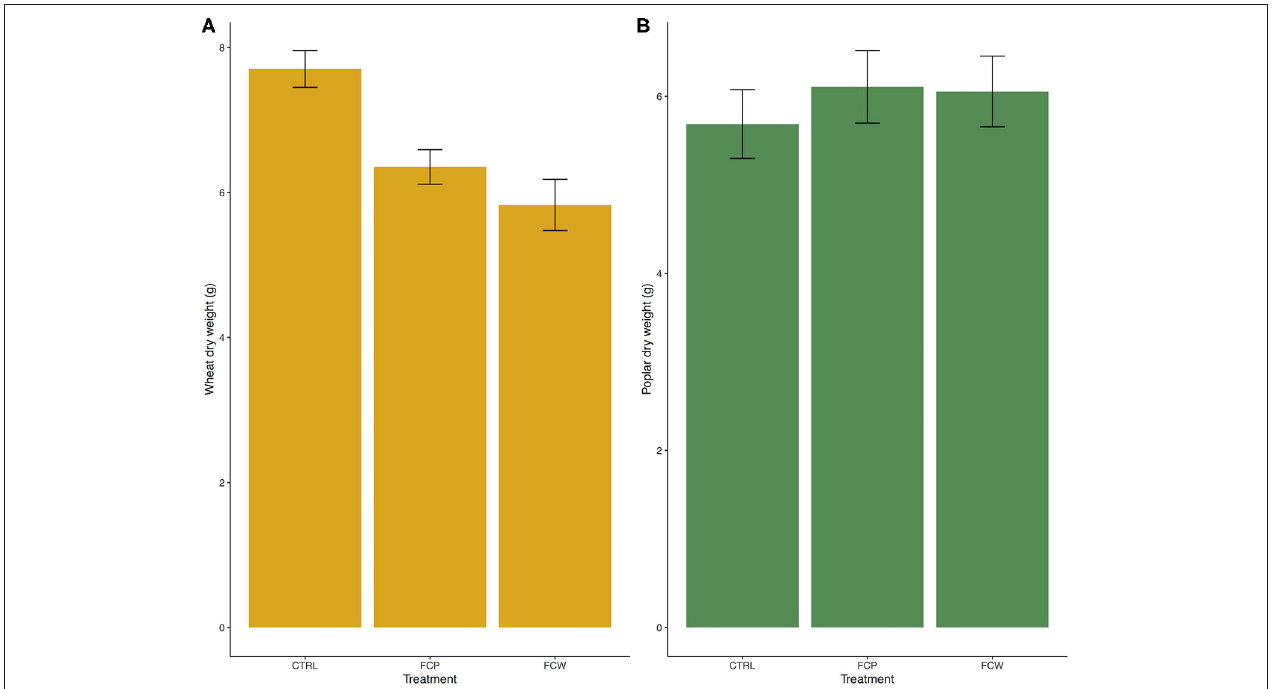
FIGURE 2 | Fusarium culmorum isolates reduced biomass in wheat (A) but not in poplars (B) . FCW: isolate of F. culmorum from wheat. FCP: isolate of F. culmorum from P. trichocarpa . CTRL: sterile water control. Bars are standard